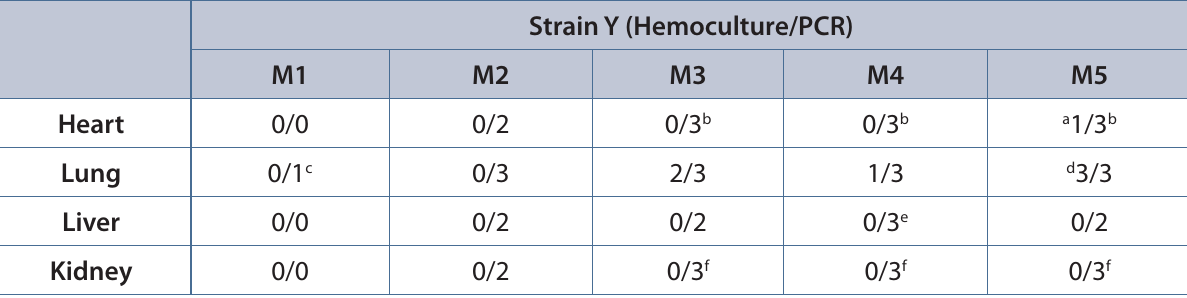
Table 1. Number of animals that tested positive by hemoculture or PCR analysis in different organs of mice infected with T. cruzi strain Y